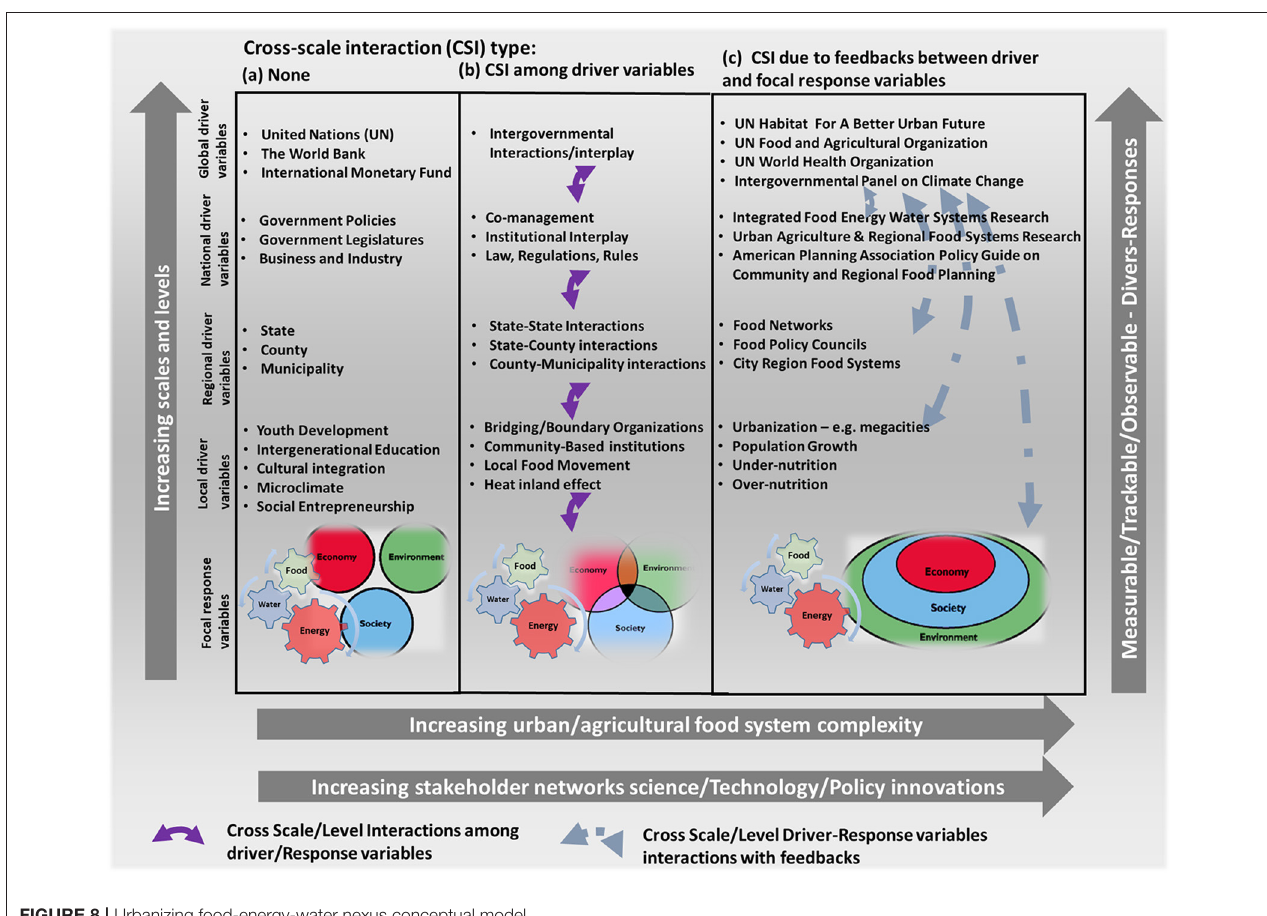
FIGURE 8 | Urbanizing food-energy-water nexus conceptual model.